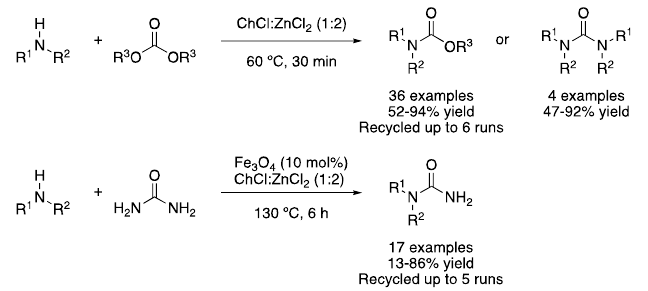
Figure 42. Synthesis of carbamates and urea